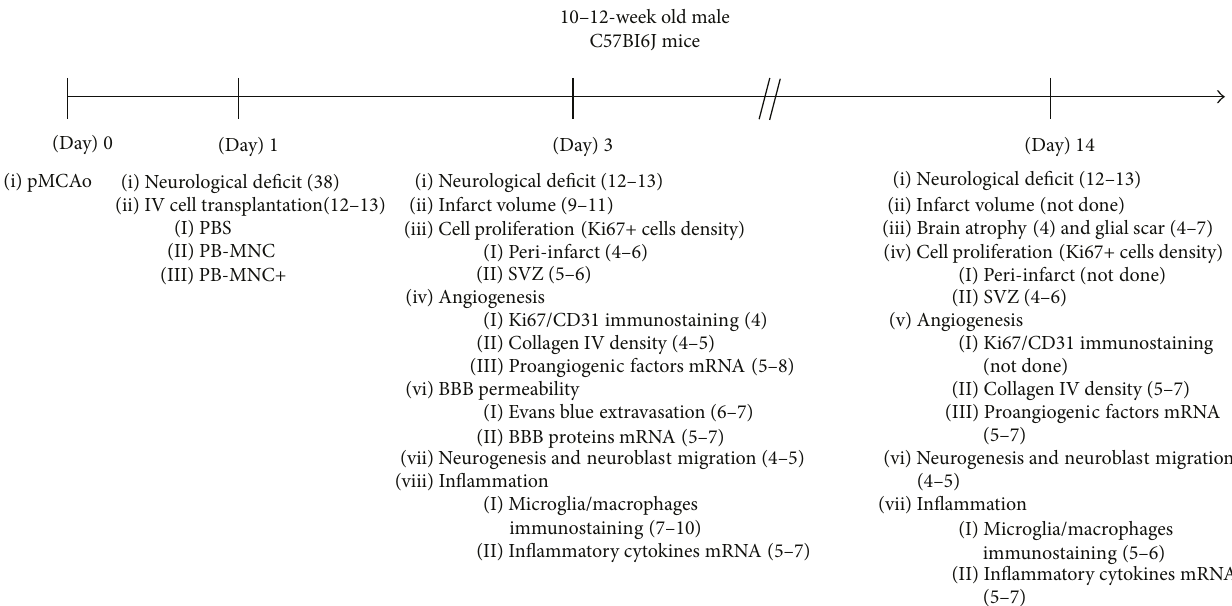
Figure 1: Experimental protocol and time schedule. pMCAo: permanent middle cerebral artery occlusion; IV: intravenous; PBS: phosphate- bu ff ered saline; PB-MNC: peripheral blood mononuclear cells; PB-MNC+: peripheral blood mononuclear cells stimulated by ephrin-B2; BBB: blood-brain barrier; SVZ: subventricular zone. There were 3 groups for each endpoint (number of mice/group). Infarct volume was not assessed at D14 because the infarct was barely detectable. Peri-infarct cell proliferation and angiogenesis evaluated on Ki67+/CD31+ double-positive cell density were not performed at D14, because of the scarce number of Ki67+ cells in the peri-infarct area at